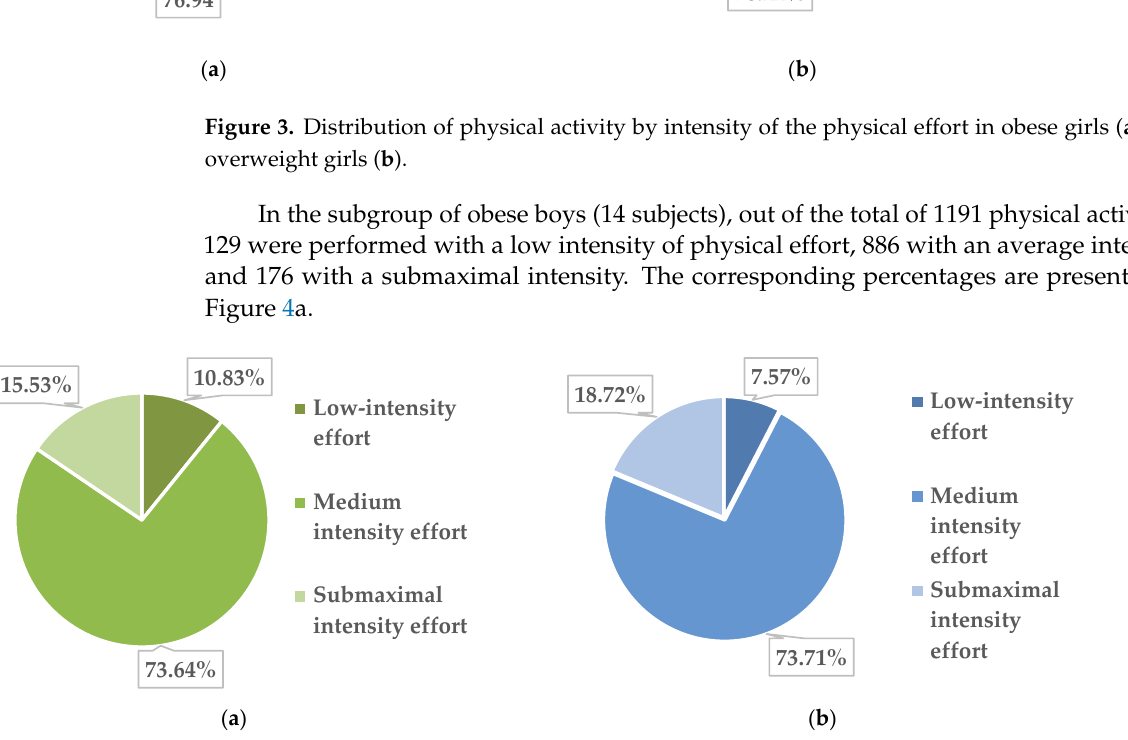
Table 7. Total number of performed physical activities by gender, weight group, and intensity of the physical effort.